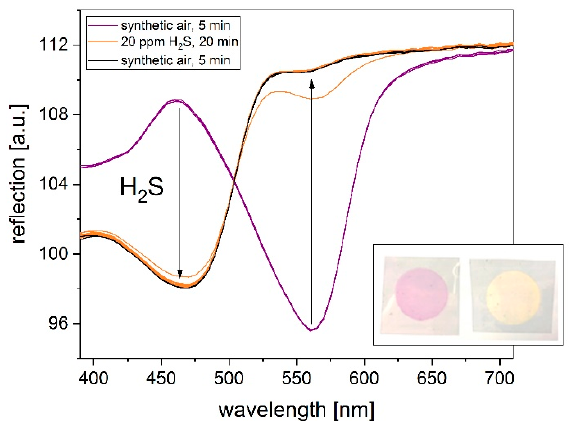
Figure 5. Reflection spectra of the Cu-PAN layer on polyethylene (PE) foil reacting to 20 ppm H 2 S in synthetic air and a relative humidity of 40% at room temperature. Recording of 15 measurement cycles with a time lag of 2 min, respectively.